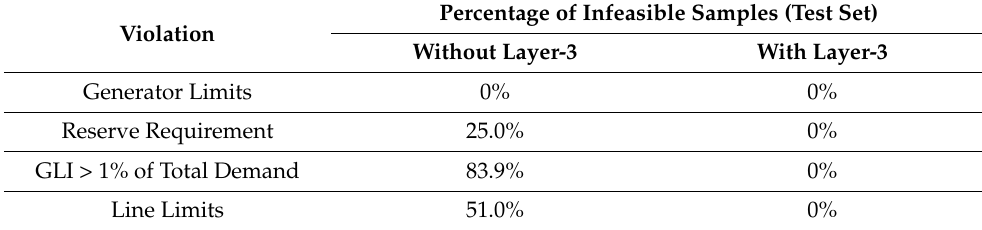
Table 11. Layer-3 Performance (IEEE 118-Bus